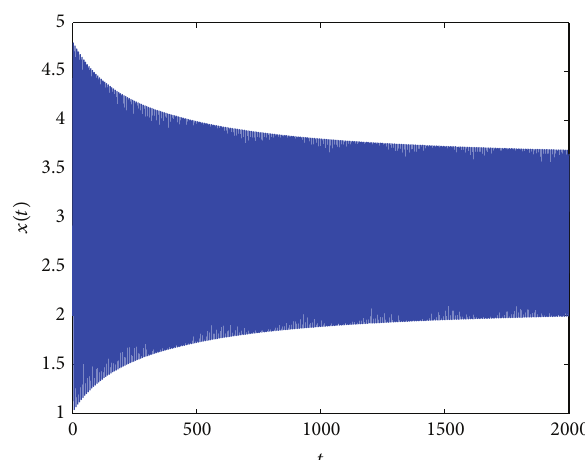
Figure 7: 𝜏 1 = 0.2046 , 𝜏 2 = 0.68 , periodic solution bifurcates from (𝑝 ∗ ,0)